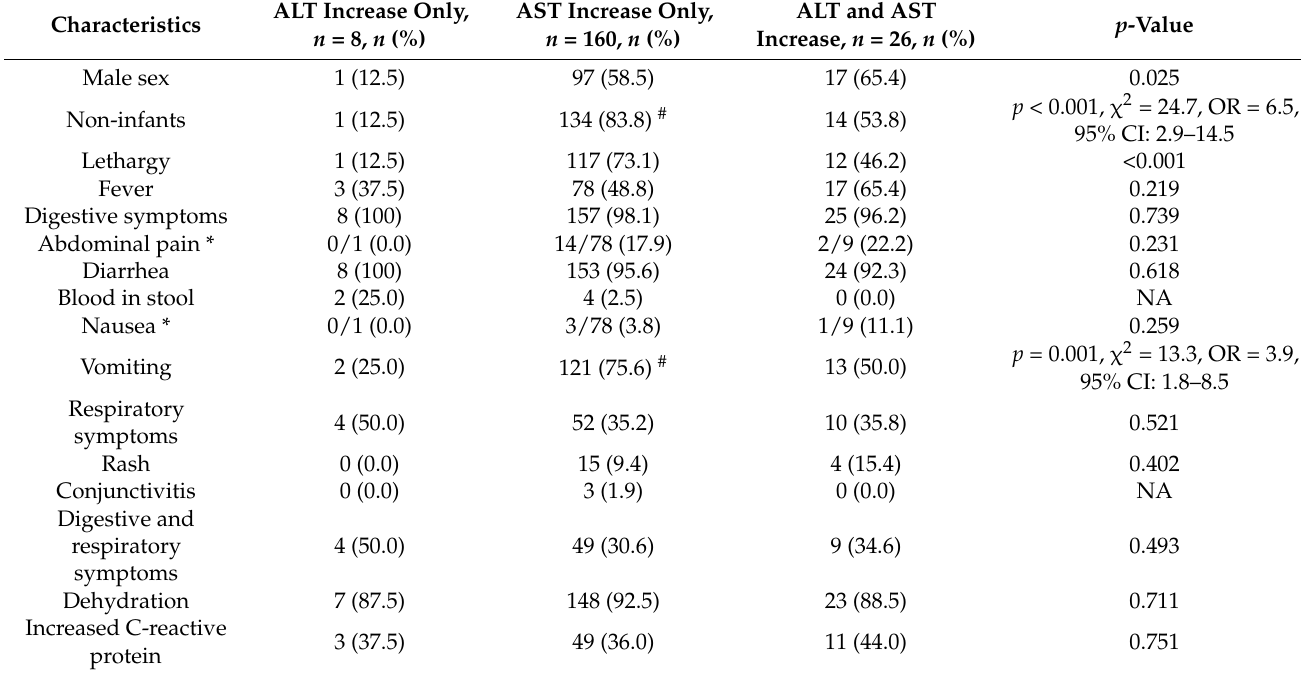
Table 5. Comparative analysis according to transaminase type after exclusion of patients with chronic conditions and